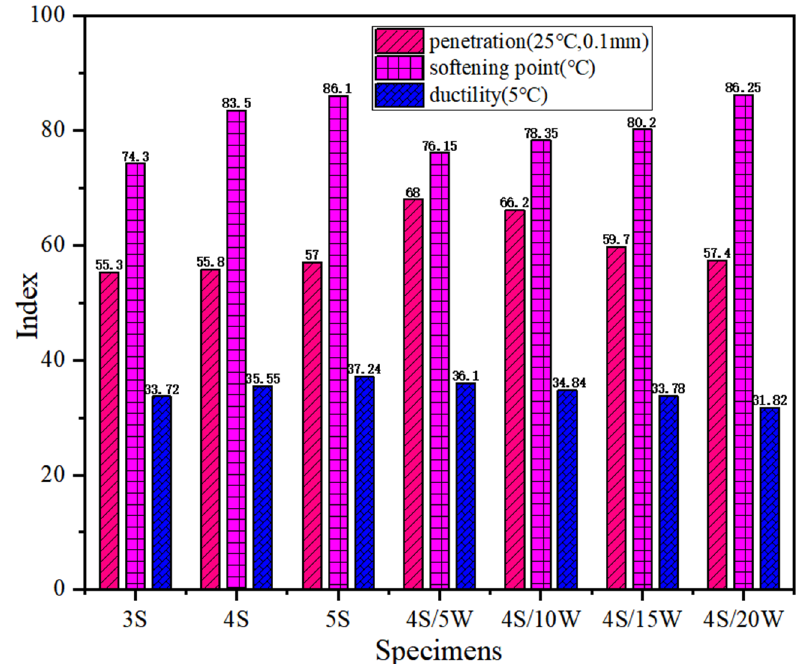
Figure 2. Conventional properties of modified asphalts.